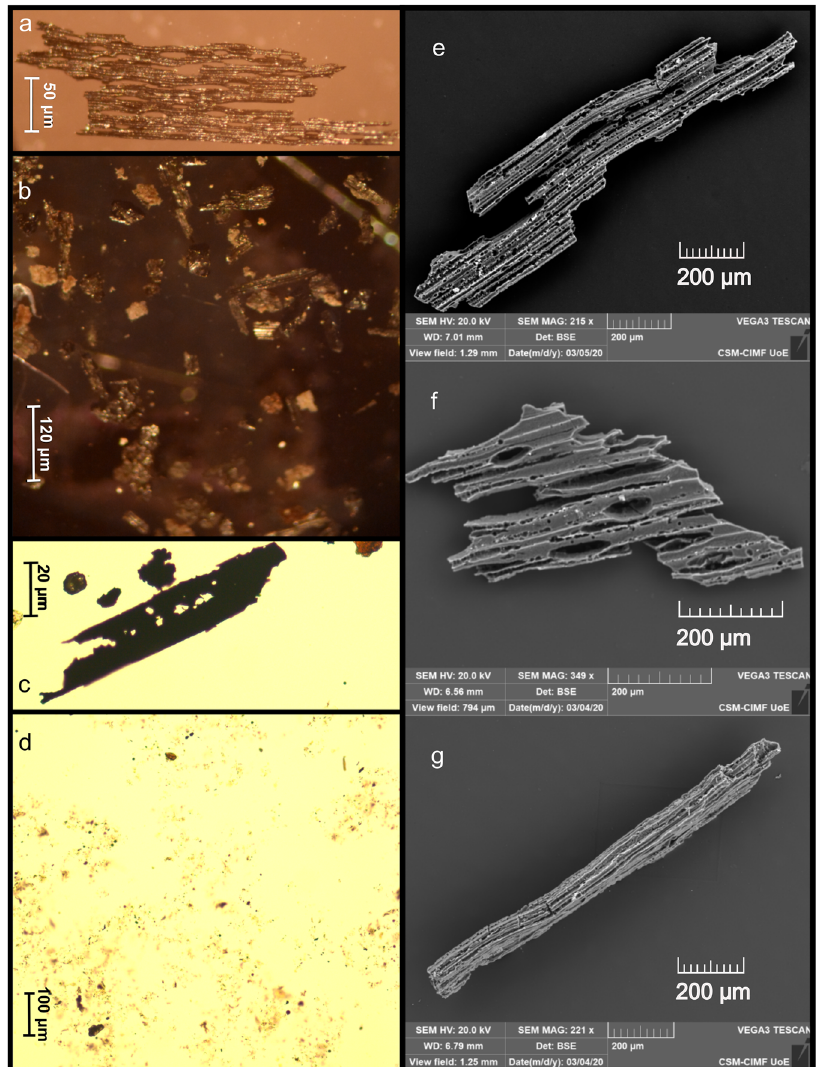
Fig. 5 Microscope images of macrocharcoal, microcharcoal and typical palynofacies of the studied interval of the Mochras borehole. a Macroscopic charcoal particle observed under the stereomicroscope. Identi fi cation characteristics are high re fl ection, brittle appearance, preserved anatomical structure and black in colour. b View of a typical macrocharcoal sample under the stereomicroscope. c Microscopic charcoal particle observed under an optical microscope, identi fi cation characteristics are opaqueness, black in colour, angular and lath-like morphology. d Typical palynofacies sample from the 934 – 951 mbs interval of the Mochras borehole. Abundant amorphous organic matter is present, with unstructured and structured terrestrial phytoclasts. e - g Scanning Electron Microscope (SEM) images of three macrocharcoal particles in the studied interval of the Mochras borehole. These charcoal particles show cellular structure, tracheids, bordering pits and